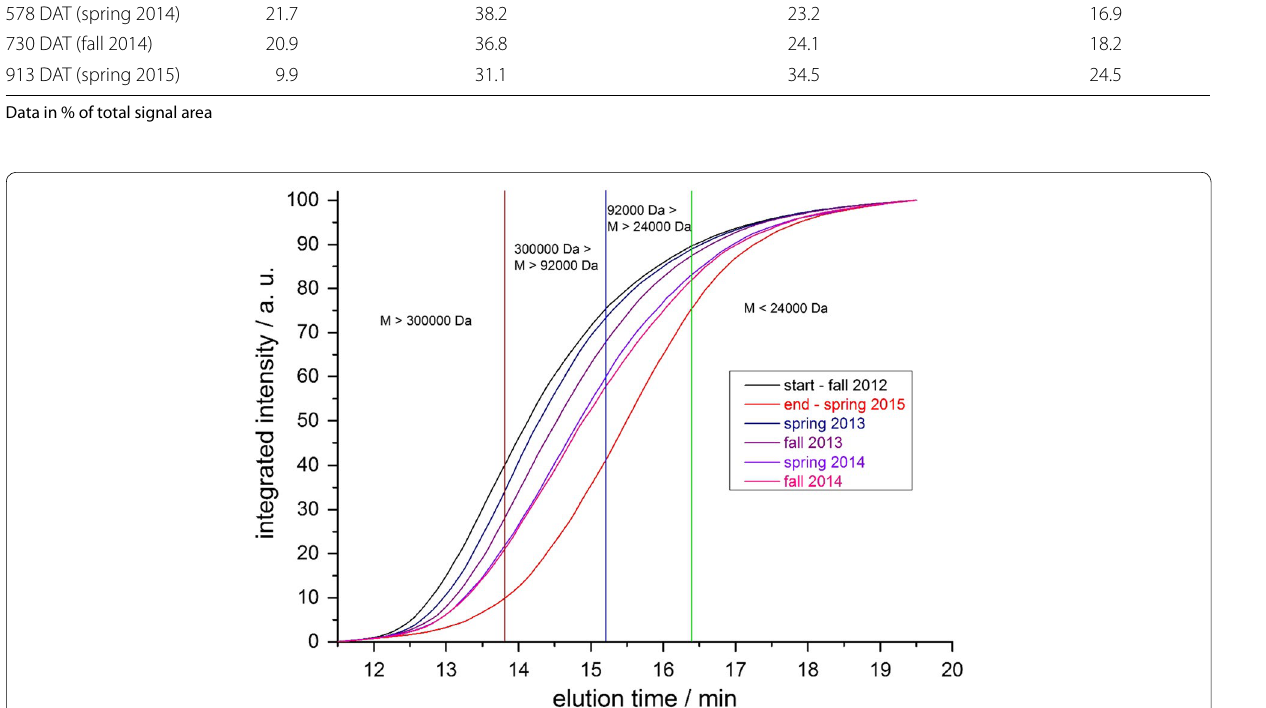
Fig. 8 Development of molar mass distribution of the lysimeter soil extracts with